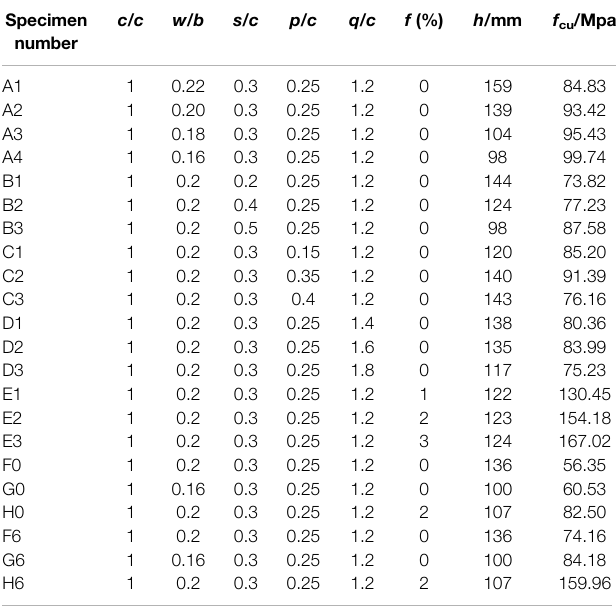
TABLE 3 | Compression test results of 22 groups of cube specimens. Specimen number